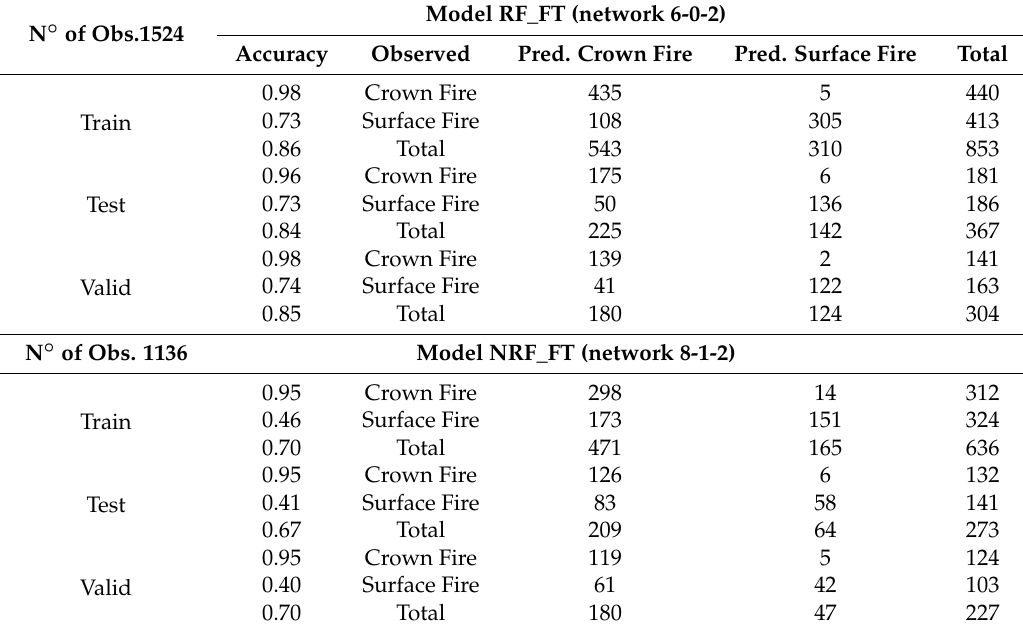
Table 4. Best model architecture and confusion matrix for the classification of Fire Type within reforested and not reforested stands (all species).